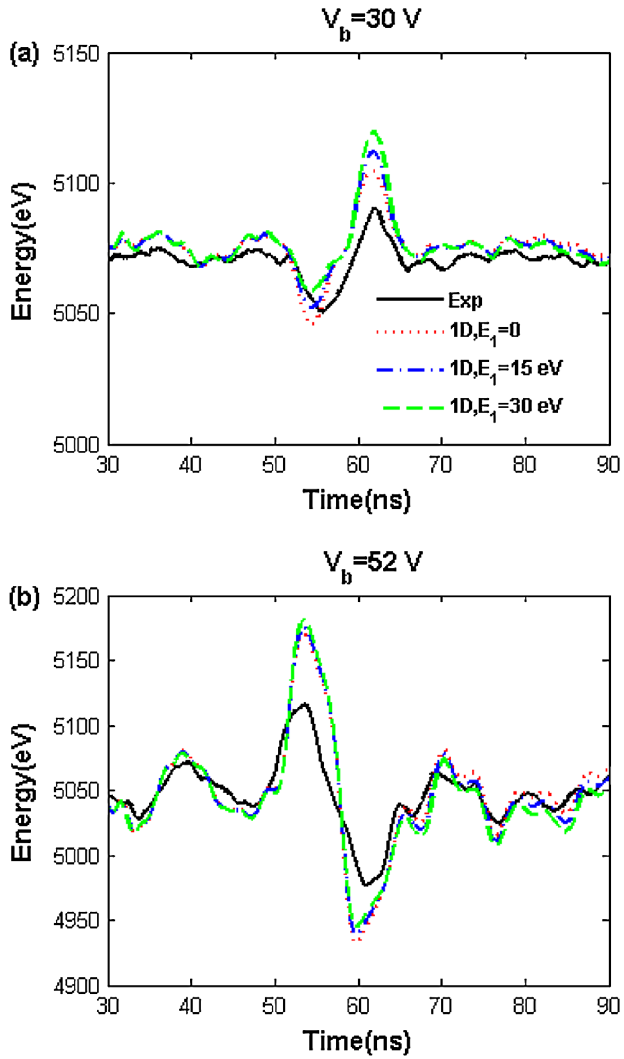
FIG. 6. (Color) Energy profiles at LC2 calculated from 1D theory along with the experimental results (black solid lines). In the 1D theory, the amplitude of initial energy perturbation is assumed to be 0, 15, and 30 eV,